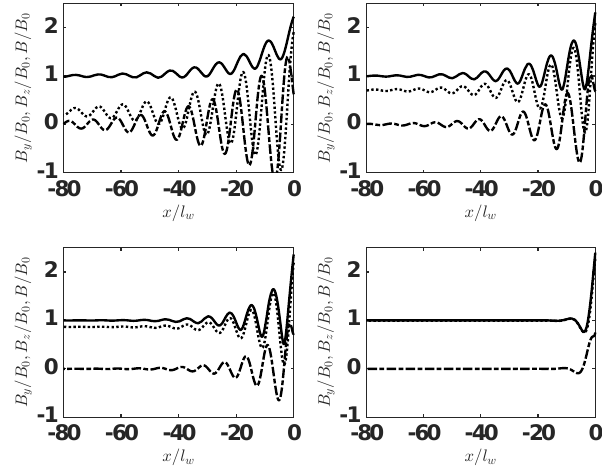
Figure 4. The total magnetic field (solid line) and the two perpen- dicular components, B z /B 0 (dotted) and B y /B 0 (dash-dotted). Top left: θ = 15 ◦ ; M = 2 . 01. Top right: θ = 45 ◦ ; M = 2 . 09. Bottom left: θ = 60 ◦ ; M = 2 . 13. Bottom right: θ = 85 ◦ ; M = 2 . 16. Other parameters: β = 0 . 2; M F = 2.